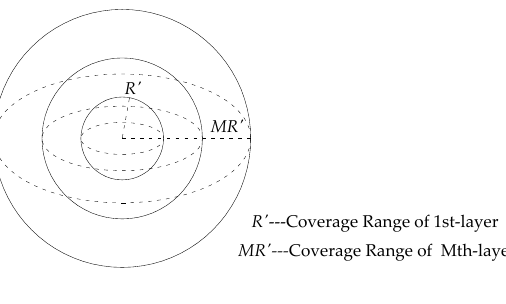
Figure 1. Spherical WSN model. Table 2. Nomenclature and typical values.